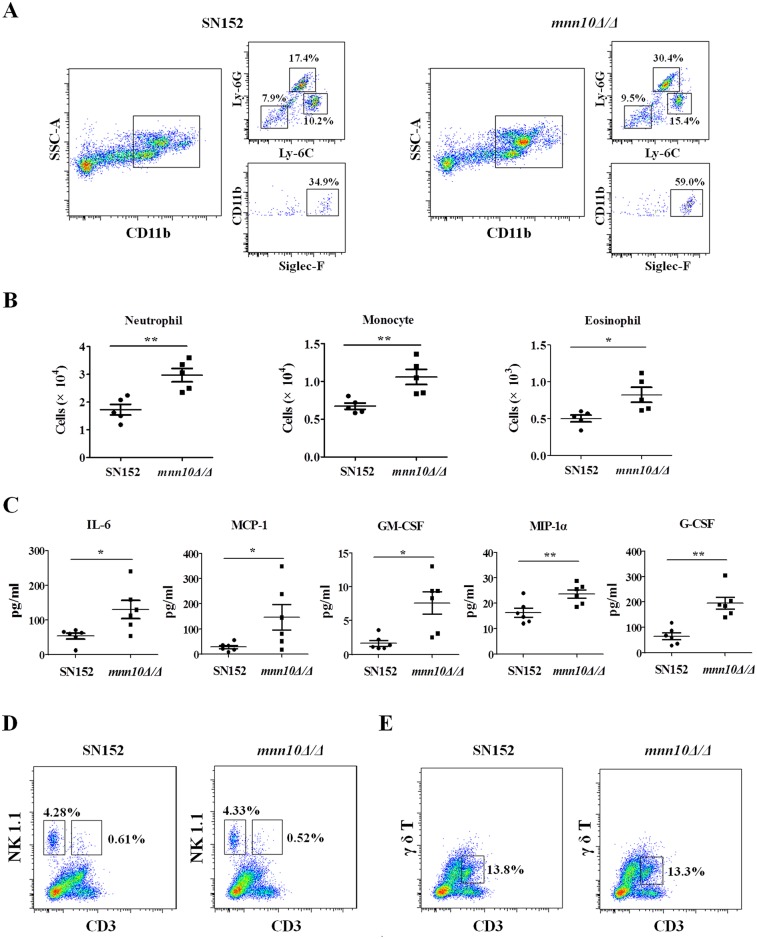

Mnn10 mutant stimulated enhanced inflammatory responses in vivo.(A, B, C) C57BL/6 mice were intraperitoneal infected with 5×105 UV-inactivated C. albicans of SN152 or mnn10Δ/Δ strain for 4 h. (A) Flow cytometry for SSChighCD11b+Ly-6C+Ly-6G+ neutrophils, SSChighCD11b+Ly-6C+Ly-6G- monocytes and SSChighCD11b+Siglec-F+ eosinophils in the peritoneum. Data are representative images of five mice. (B) Scatter plots of myeloid cell subsets in the peritoneum cavities (n = 5 per group). (C) ELISA assays for cytokines, chemokines and growth factors in lavage fluid from the inflamed peritoneal cavities (n = 6 per group). Data are representative of three independent experiments. (D, E) C57BL/6 mice were intraperitoneal infected with 5×105 live SN152 or mnn10Δ/Δ strain for 2 days. CD3-NK1.1+ NK cells (D), CD3+NK1.1+ NKT cells (D), and CD3+γ/δ T+ cells (E) in the peritoneum were detected by flow cytometry. Data are representative images of five mice. MCP-1, chemokine CCL2; MIP-1α, chemokine CCL3; GM-CSF, granulocyte-monocyte colony-stimulating factor; G-CSF, granulocyte colony-stimulating factor. *, P < 0.05; **, P < 0.01 [Mann-Whitney nonparametric t-test (B, C)].